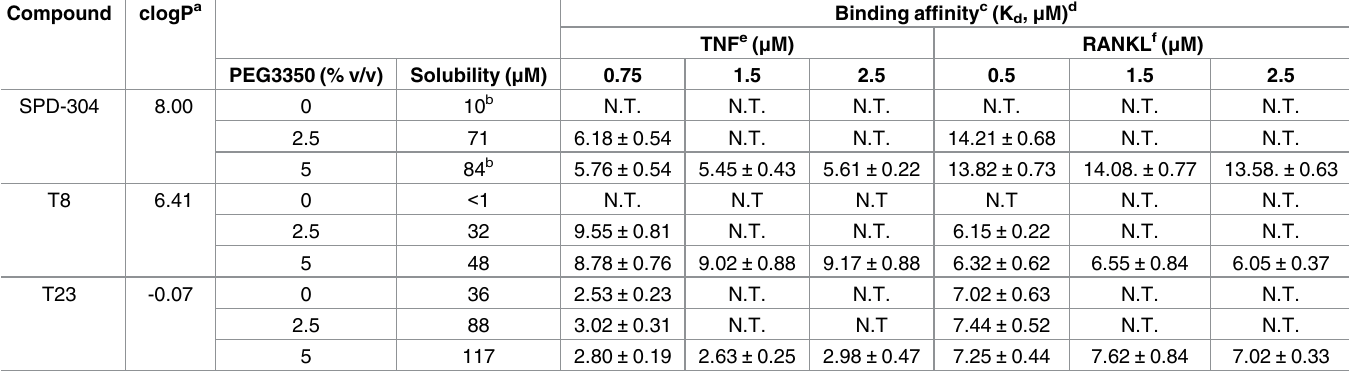
Table 6. Physicochemical properties of SPD304, T8 and T23, and determination of their dissociation constant with TNF or RANKL under different assay conditions. PEG3350was used as co-solventin order to enhanceinhibitorssolubility and thus eliminatethe possibilityof aggregatesformation.